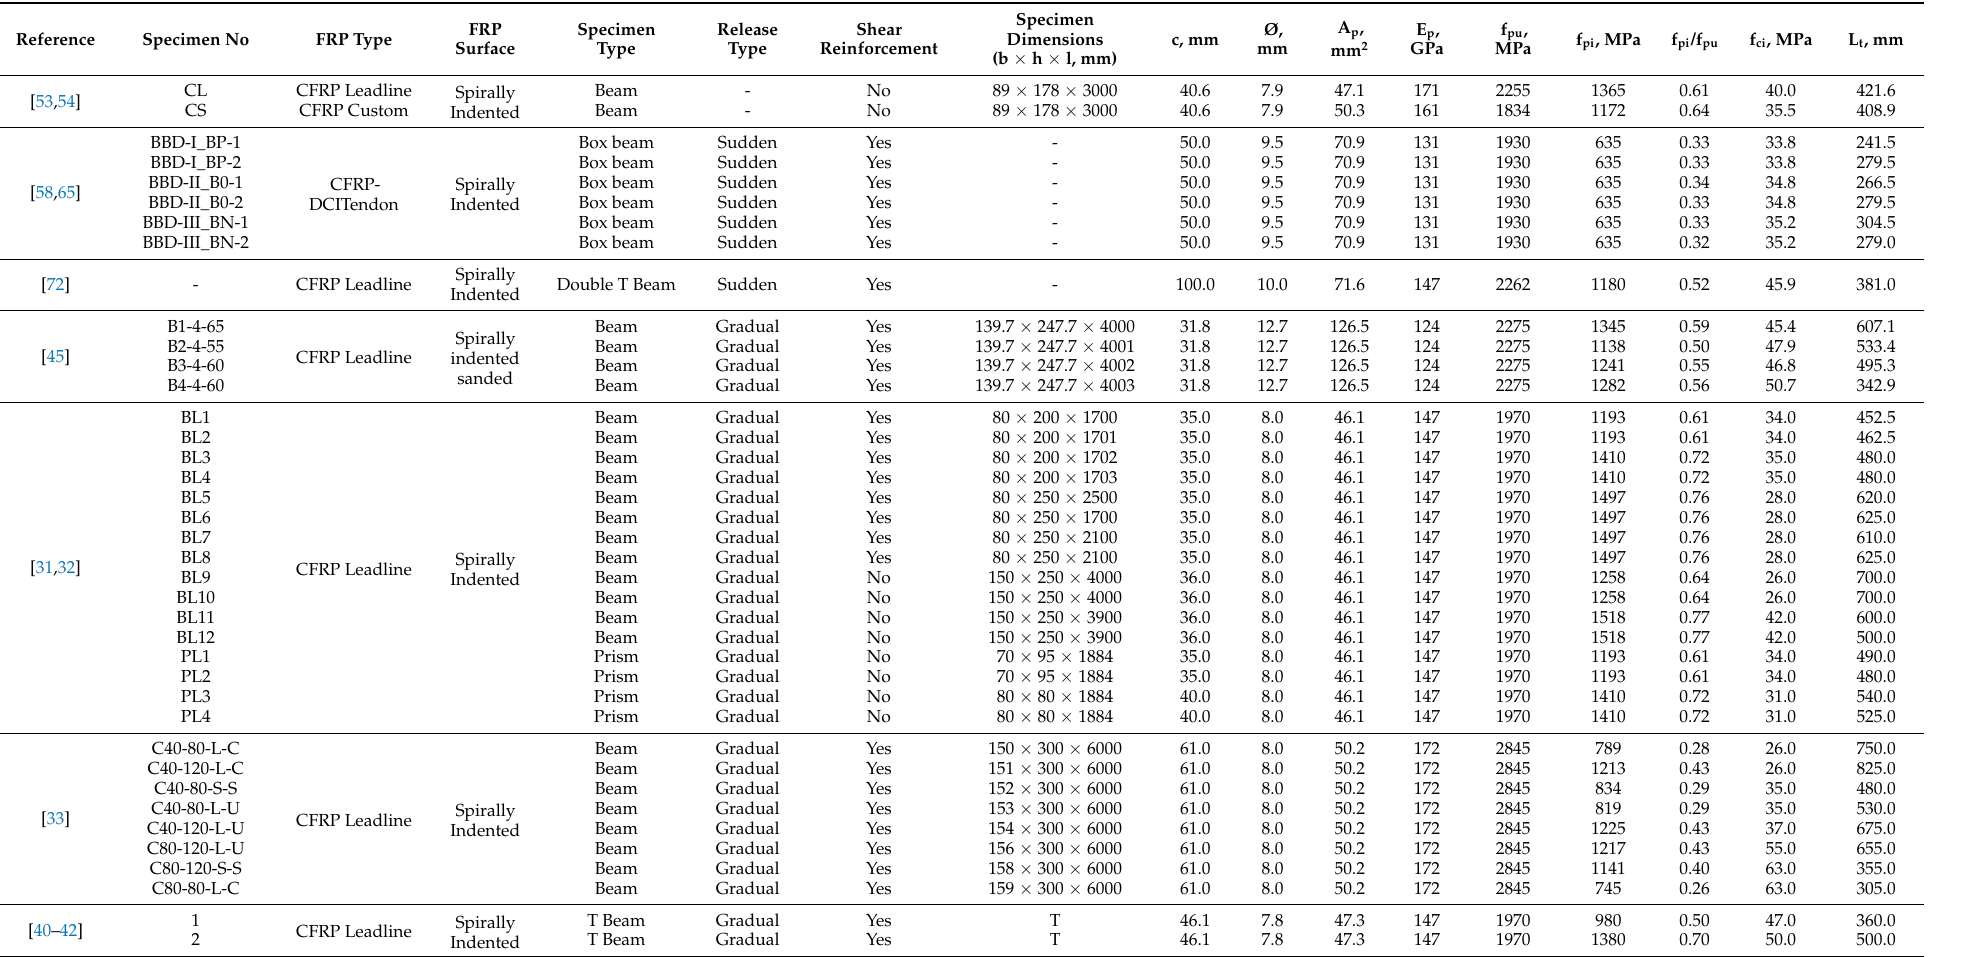
Table 3. Geometrical, mechanical properties of the material and transfer lengths of specimens with pretensioned CFRP